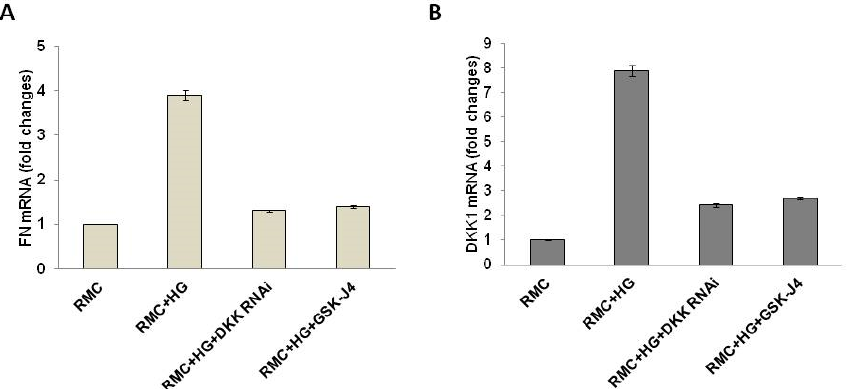
Figure 6. GSK-J4 attenuates high glucose-induced profibrotic factor expression in mesangial cells via DKK1. Cells were divided into four groups: rat renal mesangial cells (RMCs) were cultured in a basal medium containing glucose for 48 h (RMC + HD), after which DKK-1 RNAi (RMC + HD + DKK RNAi) or GSK-J4 (RMC + HD + GSK-J4) was added. Quantitative RT–PCR analyses of ( A ) FN and ( B ) DKK1. Abbreviations: FN, fibronectin; DKK1, dickkopf-1; HG, high glucose; and RMCs, rat kidney mesangial cells.